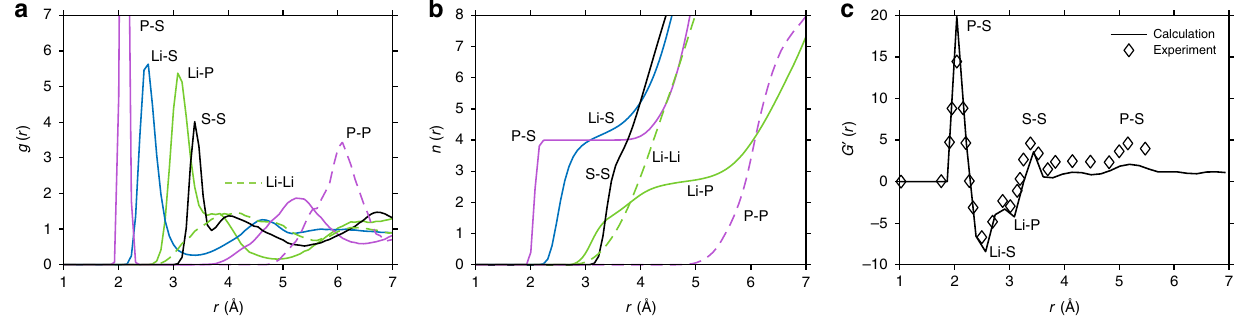
Fig. 2 Characterization of the static structure of glassy Li 3 PS 4 at ambient temperature. a Partial pair distribution function, g ( r ). b Coordination number, n ( r ). c Total neutron-weighted pair distribution function, G ’ ( r ), (solid line) compared with experimental neutron diffraction data (diamonds) reported by Ohara et al. 7 . Atom pair distances associated with the peaks in G ’ ( r ) are